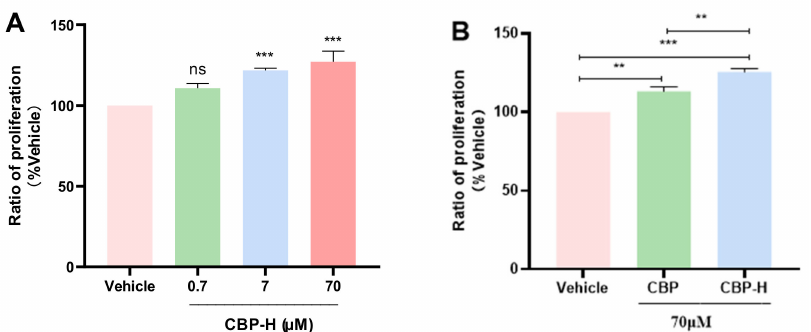
Figure 6. Effects of CBP- H and CBP on cell proliferation. ( A ) CBP-H at concentrations of 0.7, 7, and 70 µ M was tested for inducing cell proliferation at72 h. ( B ) CBP-H and CBP at concentrations of 70 µ M were tested at 72 h. MTT assays were performed by measuring absorbance at 570 nm. n = 5, data are presented as means ± SEMs and analyzed by one-way ANOVA followed by Tukey’s multiple comparison test. ** p < 0.01, and *** p < 0.001 vs. vehicle.